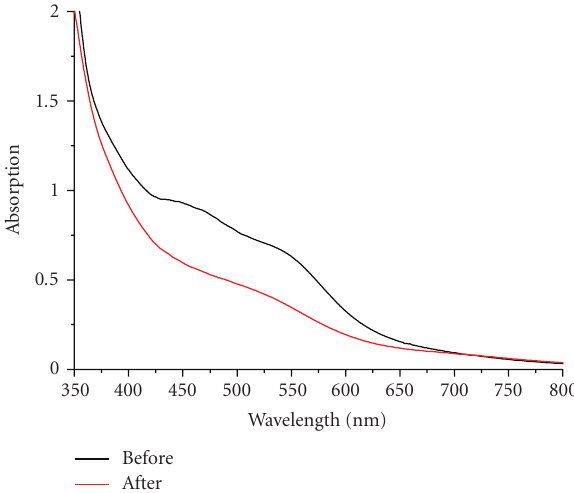
Figure 4: Time-current curve of the cell with E322. The short cir- cuit photocurrent was recorded continuously at the light intensity of 1000 Wm − 2 .